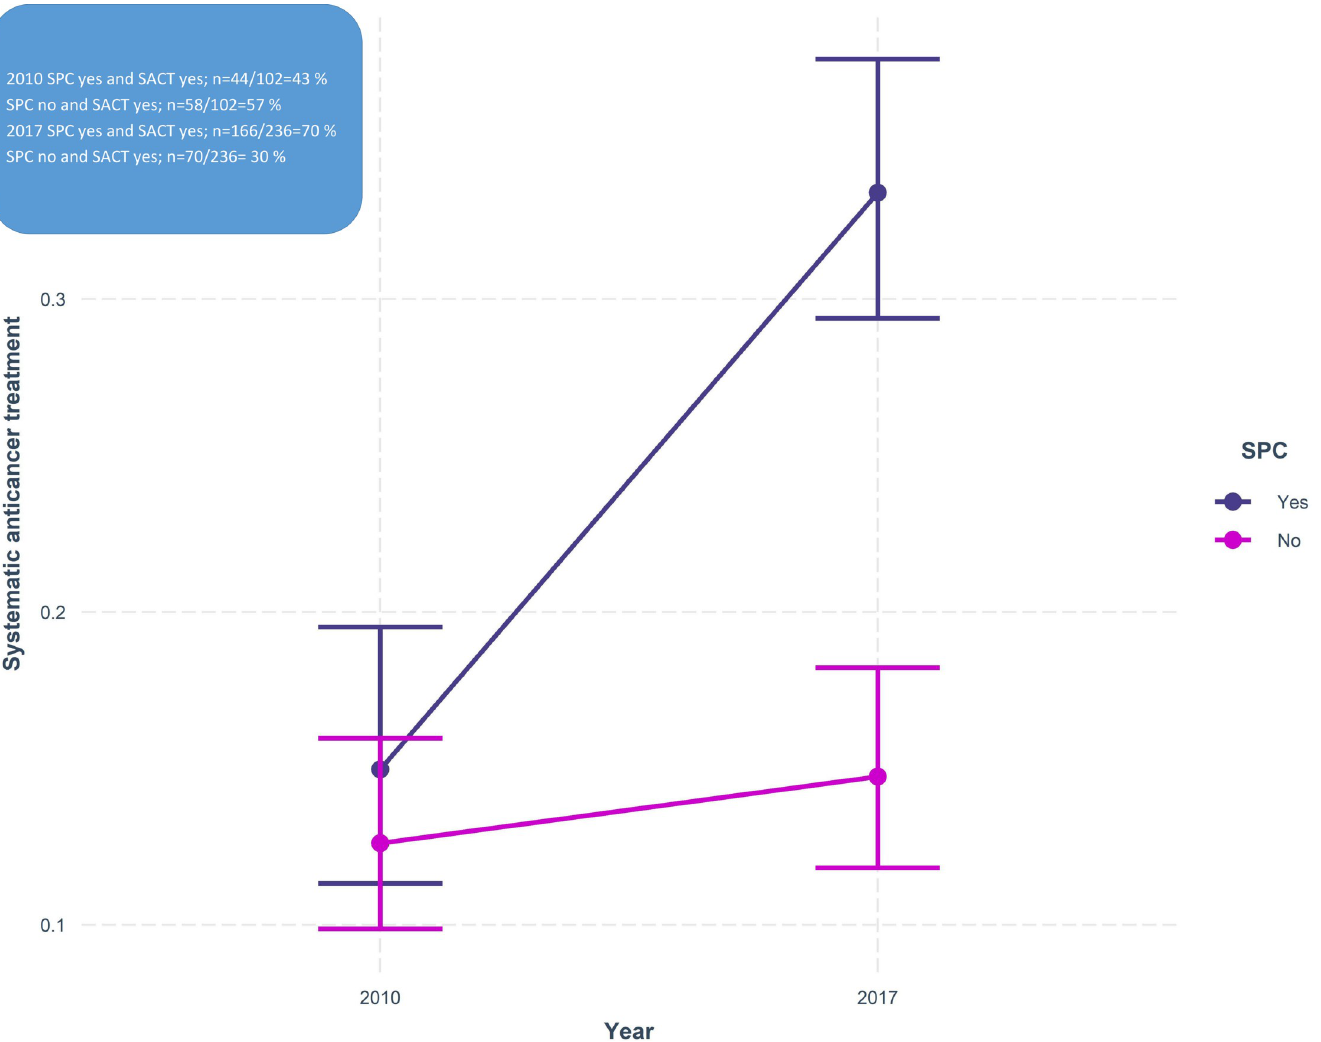
Fig 2. Moderation effects of specialized palliative care (SPC) at home on the difference between the years of 2010 and 2017 in patients receiving systematic anticancer treatment last 30 days of life.